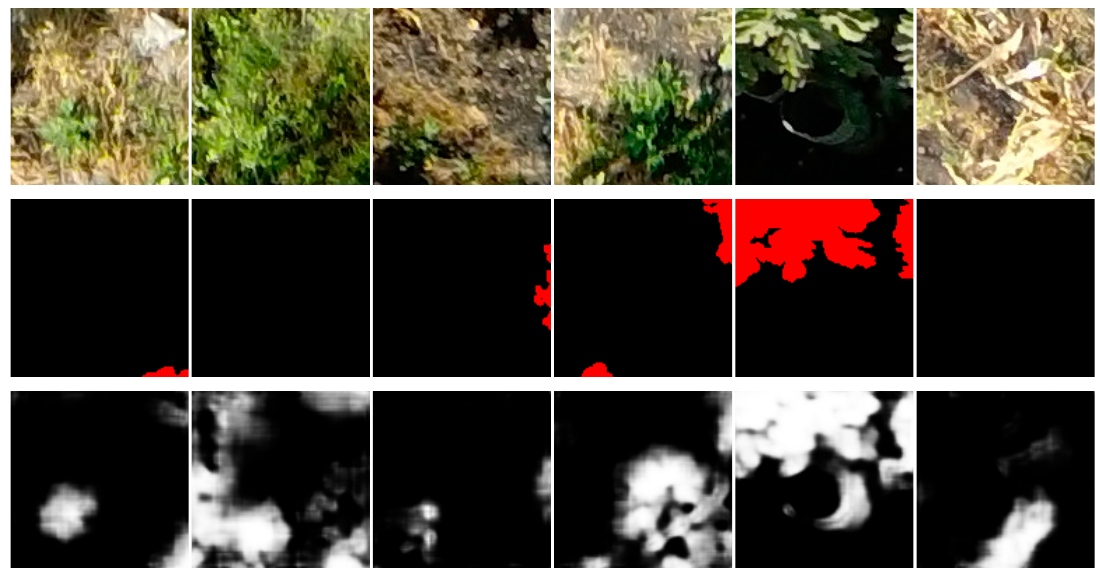
Figure 9. Some problems identified: RGB image inputs (first row), GT (second row) and Predictions (third row).